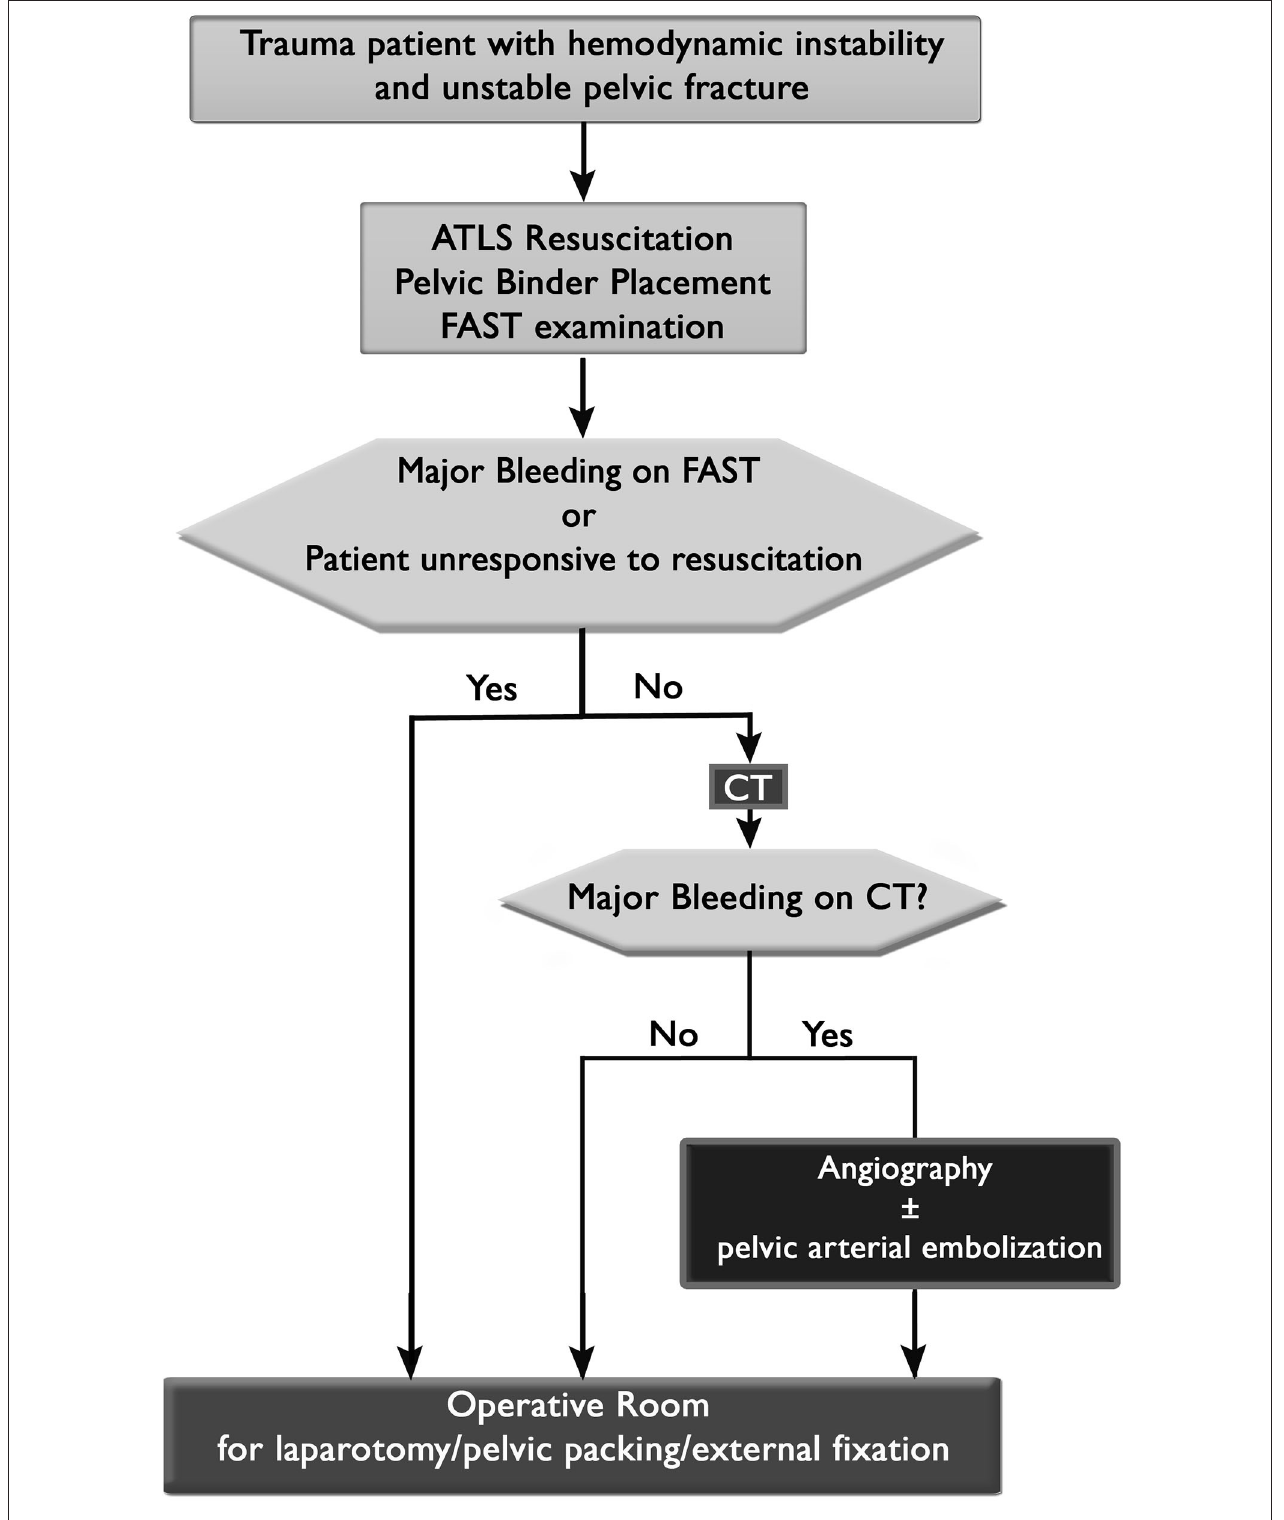
FIGURE 1 | Triage algorithm for patients with hemodynamic instability and unstable pelvic ring injuries.